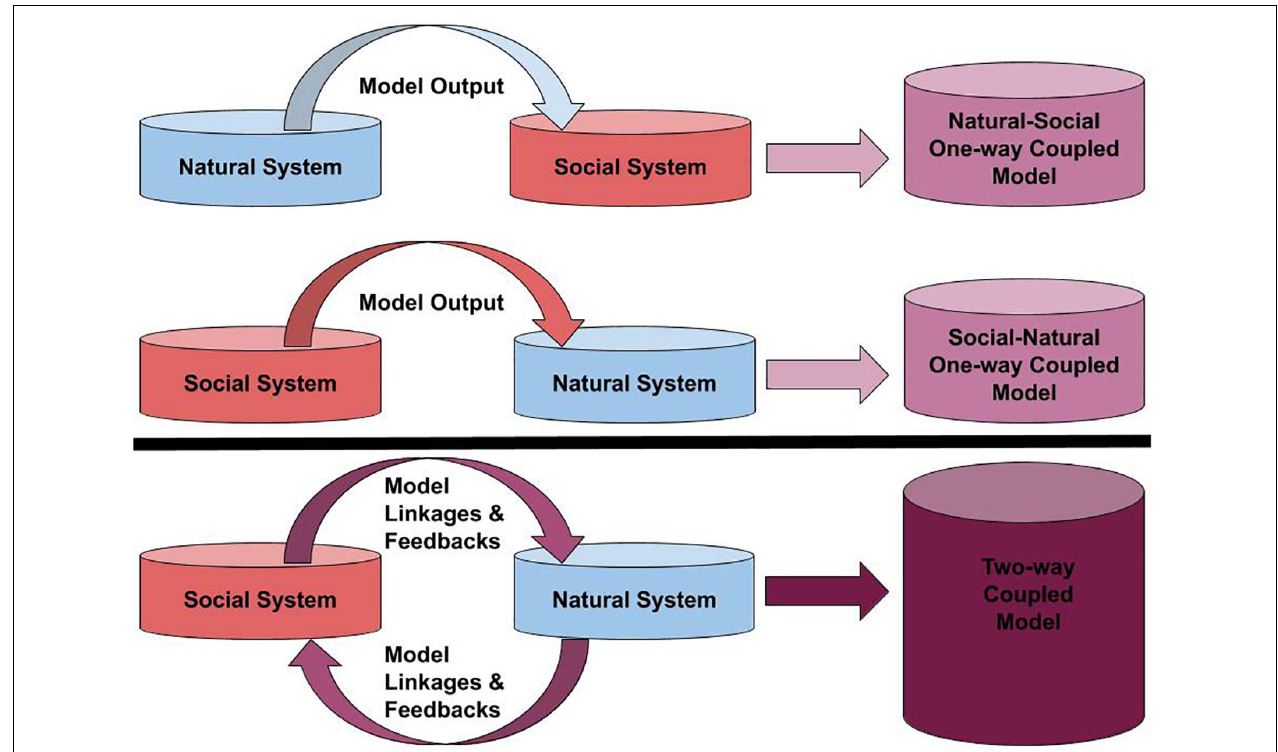
FIGURE 1 | Conceptual Relationship Between One-way and Two-way Coupled Social-Ecological Models.